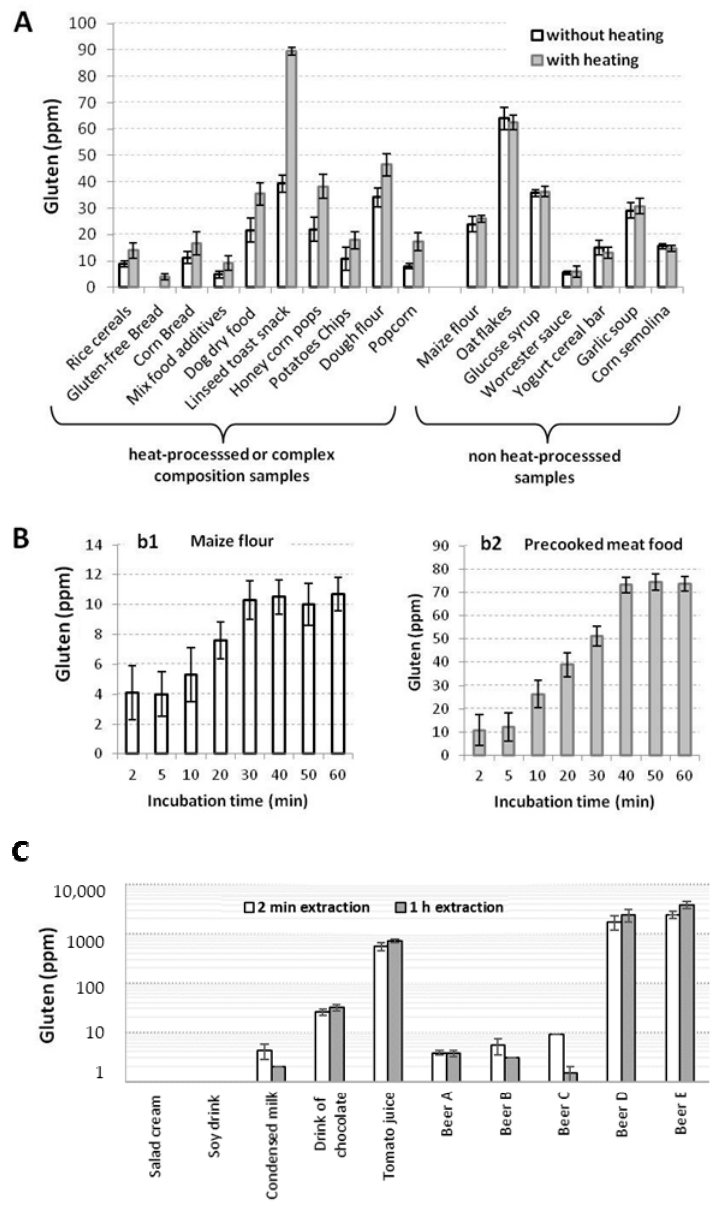
Figure 1. Optimization of time and temperature in the Universal Gluten Extraction Solution (UGES) protocol. ( A ) Effect of temperature in different types of samples. ( B ) Effect of time in simple and complex solid samples. ( C ) Effect of extraction time in liquid samples without suspended